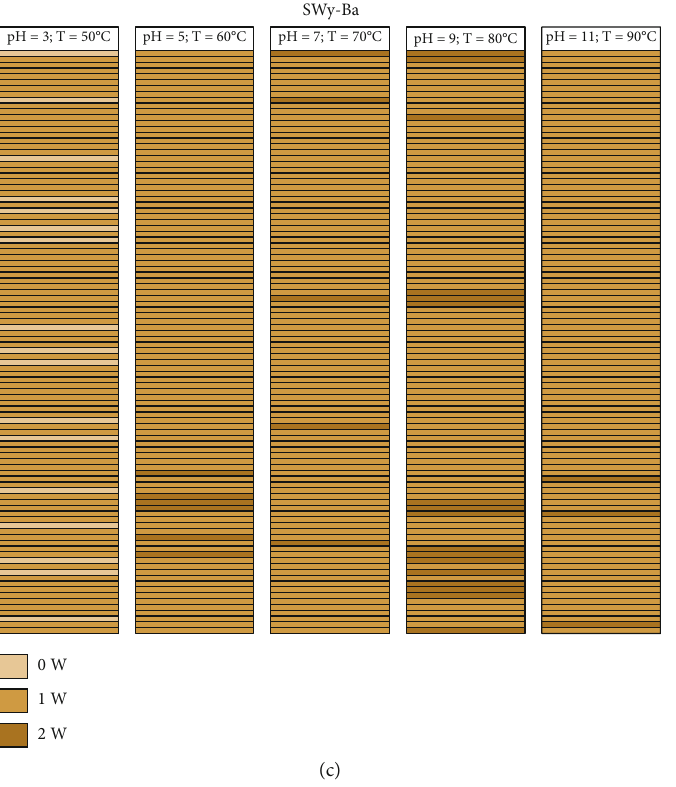
Figure 11: Mapping representation of the hydration state in the case of SWy-Co (a), SWy-Cu (b), and SWy-Ba (c) samples via XRD modeling